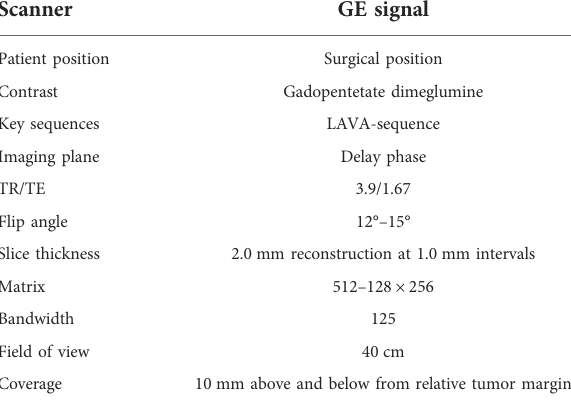
TABLE 1 MRI parameters for three-dimensional reconstruction in the current research.